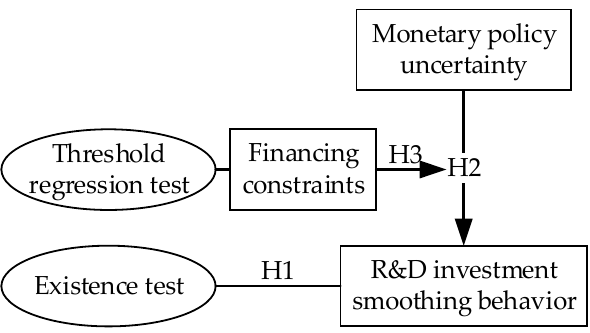
Figure 1. The theoretical model of the paper.